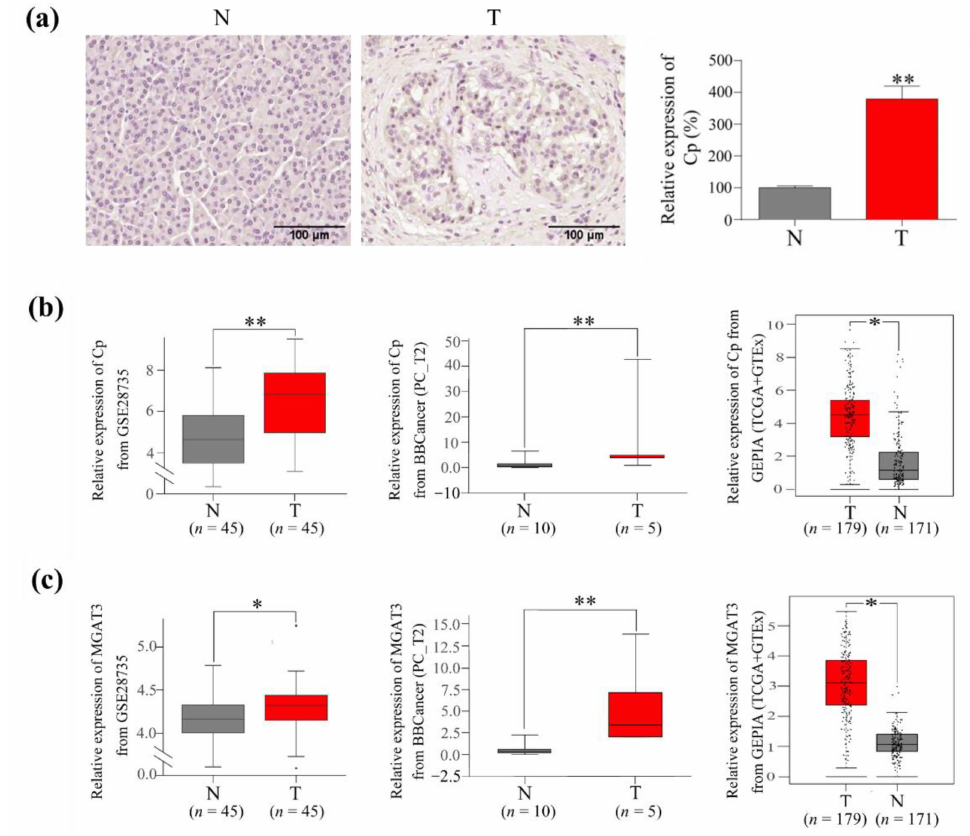
Figure 5. The expression of Cp and GnT III in PC tissues. ( a ) The expression of Cp in paired PC tissue and adjacent normal pancreatic tissue were analyzed by immunohistochemistry (IHC).